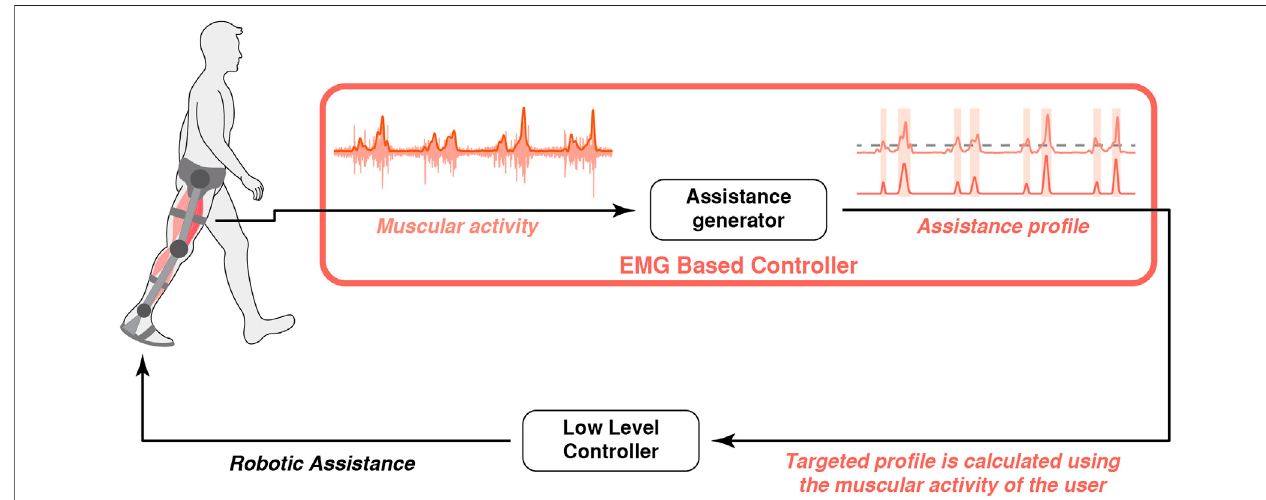
FIGURE6| Conceptualrepresentationoftherobot-gaitcoordinationbasedontheEMGsignalsfromtheuser:thecontrollergeneratesanassistancewhosetiming and amplitude depend on the muscular activity.